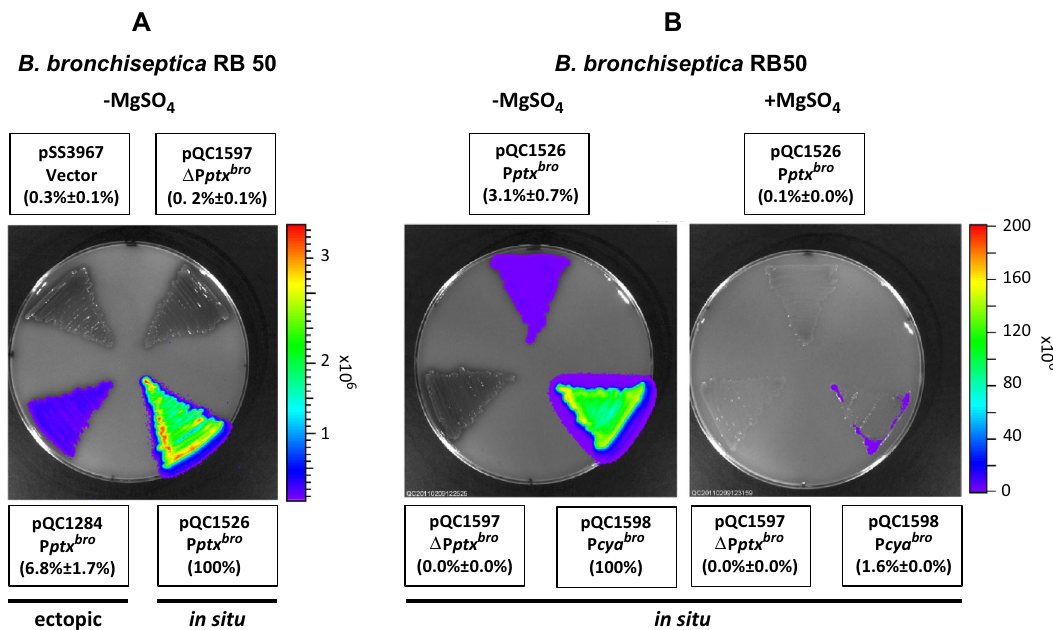
Figure 2. Low but detectable P ptx bro transcriptional activity in B. bronchiseptica. ( A ) Plasmid pQC1284 containing P ptx bro (− 290 to + 28), fused to luxCDABE in vector pSS3967, was integrated into B. bronchiseptica RB50 to generate an ectopic lux fusion (bottom left), and the plasmid pQC1526 containing a larger region of P ptx bro (− 1170 to + 28), fused to luxCDABE in the vector pSS4162, was integrated into B. bronchiseptica RB50 to generate an in situ lux fusion in its native context (bottom right). The empty vector pSS3967 was integrated into B. bronchiseptica RB50 to serve as a negative control for the ectopic fusion (Vector, top left), and plasmid pQC1597 containing a deletion of P ptx bro (− 167 to + 4) from pSS1526 was integrated into B. bronchiseptica RB50 to serve as negative control for the in situ fusion (ΔP ptx bro , top right). ( B ) Plasmid pQC1598 containing P cya bro and upstream sequences (− 930 ~ + 37), fused to luxCDABE in vector pSS4162, was integrated